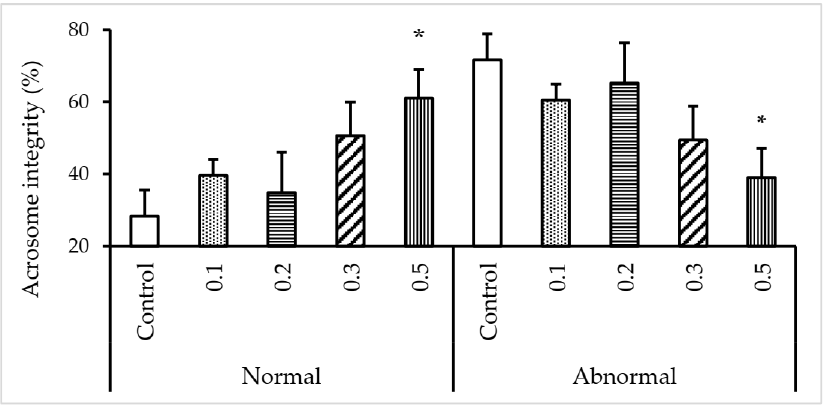
Figure 2. Effect of different κ -carrageenan concentrations in egg yolk-free extender on the acrosome integrity of canine sperm following freezing-thawing. FT spermatozoa were stained with PSA/FITC and examined under green fluorescence. Spermatozoa with intact acrosome were considered normal while those with damaged acrosome were considered abnormal. (*) Above the bar indicate significant differences between groups ( p < 0.05). Error bars show the standard error of the mean.